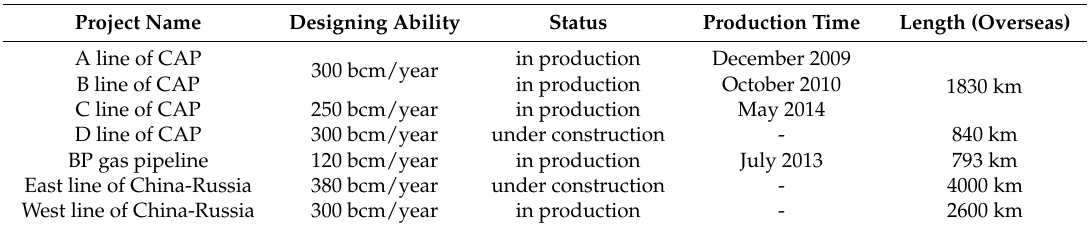
Table 3. Imports of long-distance natural gas pipeline.